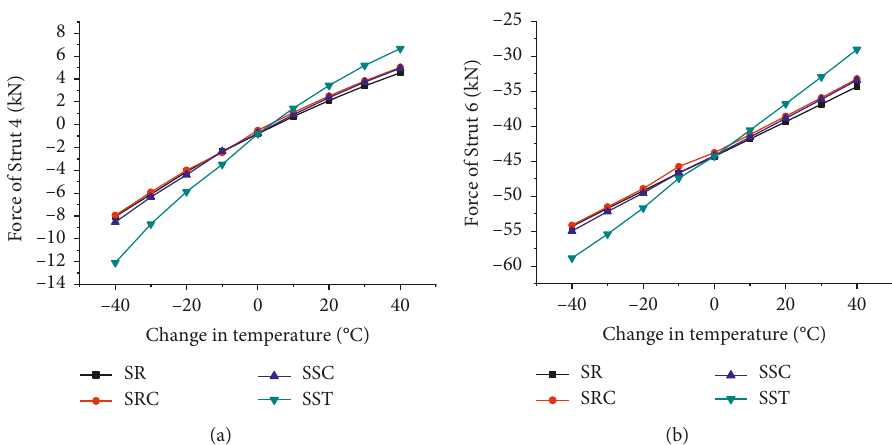
Figure 11: Relationship between the strut force and the temperature in the half-span load distribution. Change in the force of (a) Strut 4 and (b) Strut 4 with varying